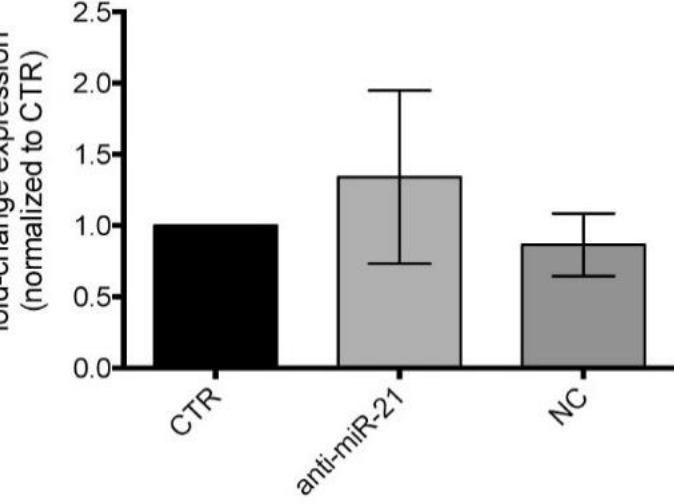
Figure 6. Western blot of STAT3 protein expression levels in LFs treated with anti-miR-21. Quantifi- cation of immunoblots using anti-STAT3 of LFs from BAL of CLAD patients treated with anti-miR-21 after 48h. Control cells (CTR); negative control treated cells (NC).